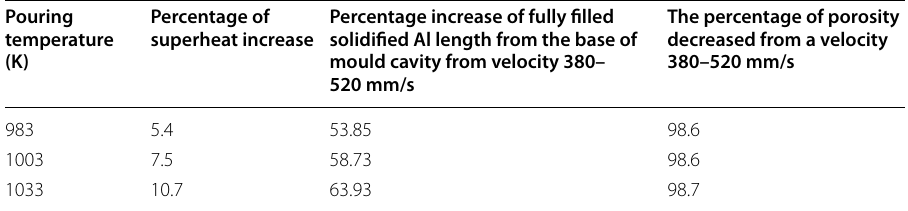
The percentage of porosity decreased from a